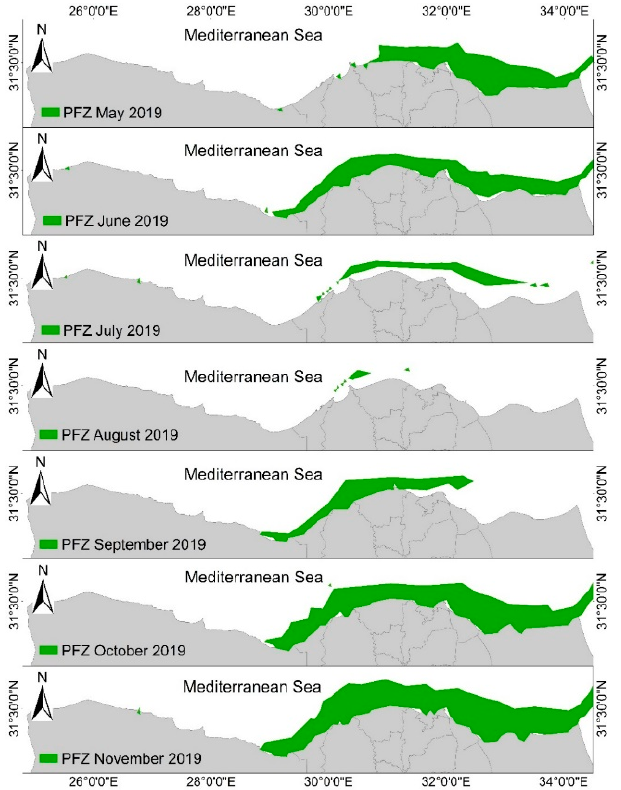
Figure 7. The monthly detected Potential Fishing Zones for Sardinella aurita over 2019 (May– November).